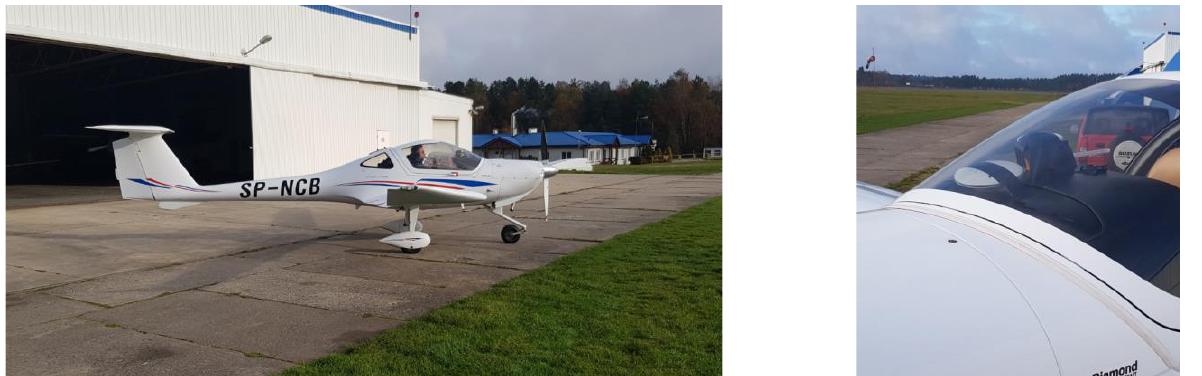
Figure 2. The Diamond DA 20-C1 aircraft taking part in the experiment and location of the GNSS antennas [45].